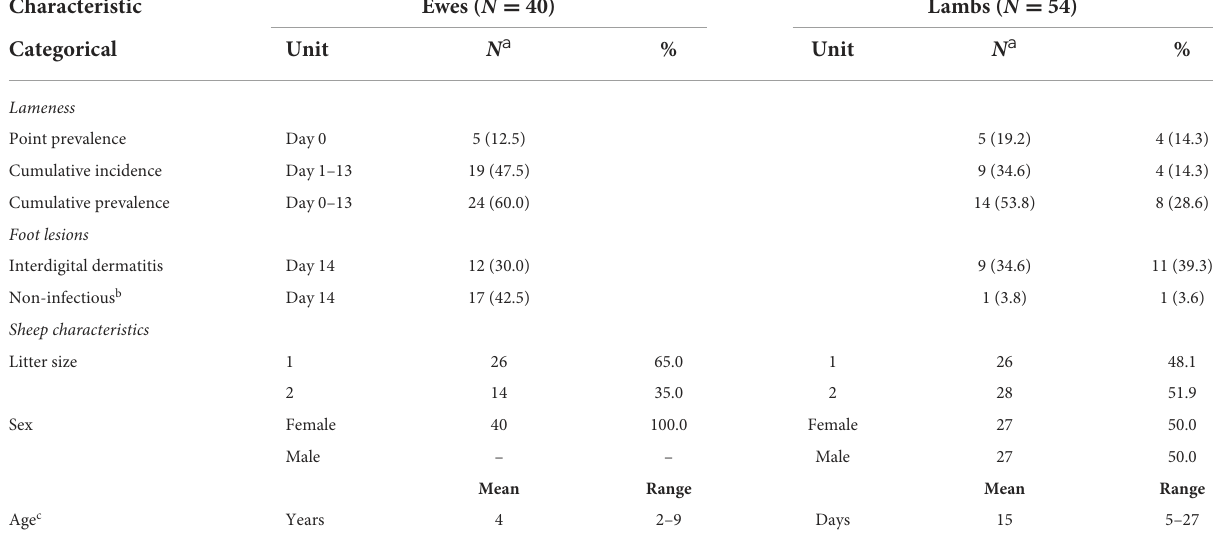
TABLE 2 Descriptive characteristics for the 40 ewes and their 54 lambs with 13 days of midnight-midnight contact data and complete locomotion records. Characteristic